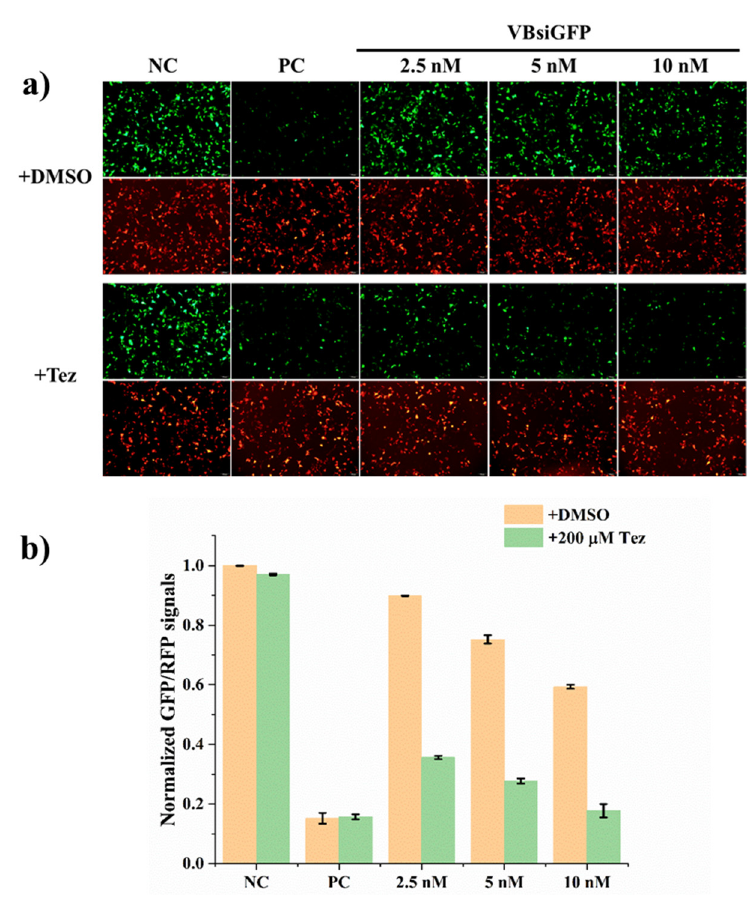
Figure 2. Bioorthogonal activation of VB-caged siRNA for GFP gene silencing with tetrazine (200 µ M). The concentration of positive control (PC) siRNA is 5 nM. ( a ) Fluorescence imaging of the GFP and RFP expression; ( b ) quantification of GFP average fluorescence intensity normalized by RFP average fluorescence intensity using flow cytometry. At least three independent experiments were performed. Error bars represent standard deviations.